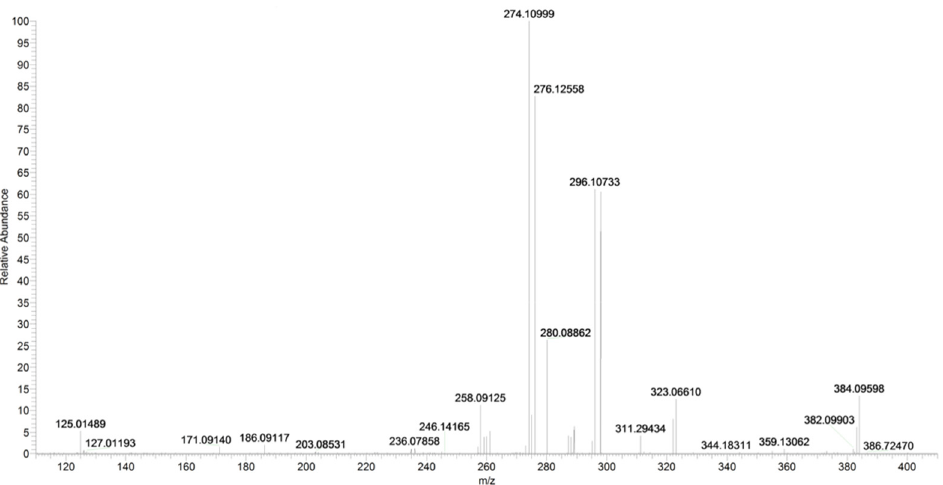
Figure 20 . Product ion scan of URB447 compound obtained by HRMS. Figure 20. Product ion scan of URB447 compound obtained by